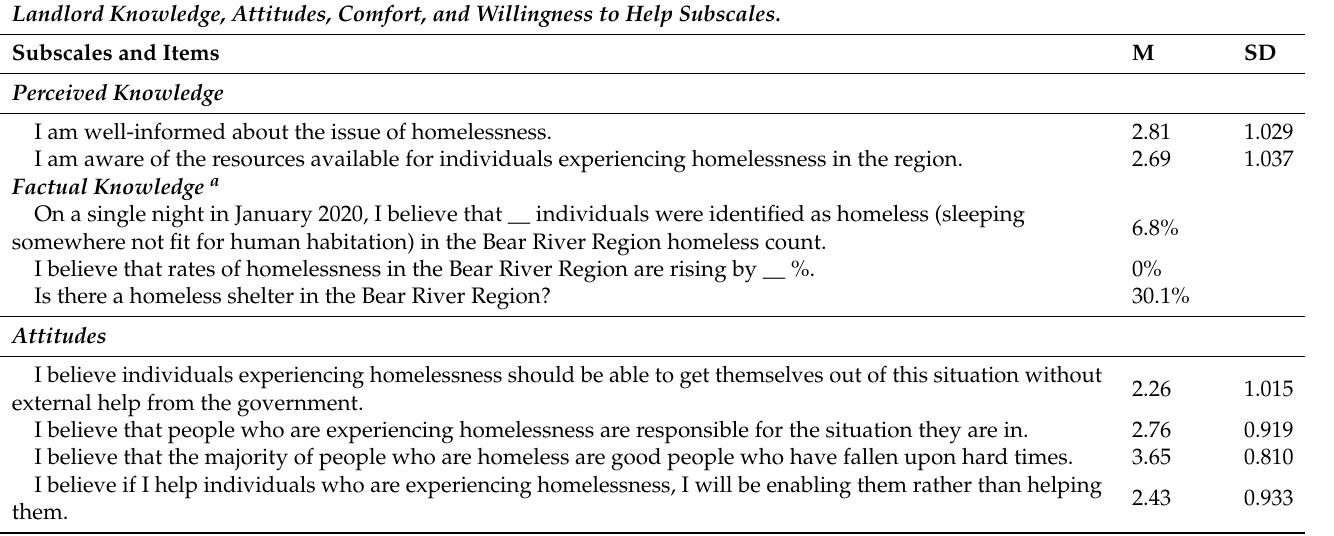
Table 2. Landlord knowledge, attitude, and willingness to help subscales. This table provides the subscales and re- spective items from the survey related to landlord knowledge, attitude, and willingness to help address homelessness. a For factual knowledge questions, participants were asked about the extent of homelessness and the rates with which it is increasing/decreasing; they were presented with four multiple choice answers. Additionally, their knowledge about whether or not an emergency shelter existed in the community was tested; percentages for each factual knowledge item indicate the percent of the sample that answered each question correctly. b Landlord comfort response categories were 1 = not comfortable, 2 = comfortable, and 3 = it depends, I would need more specific information. Only percentages that indicated “comfortable” are noted in the